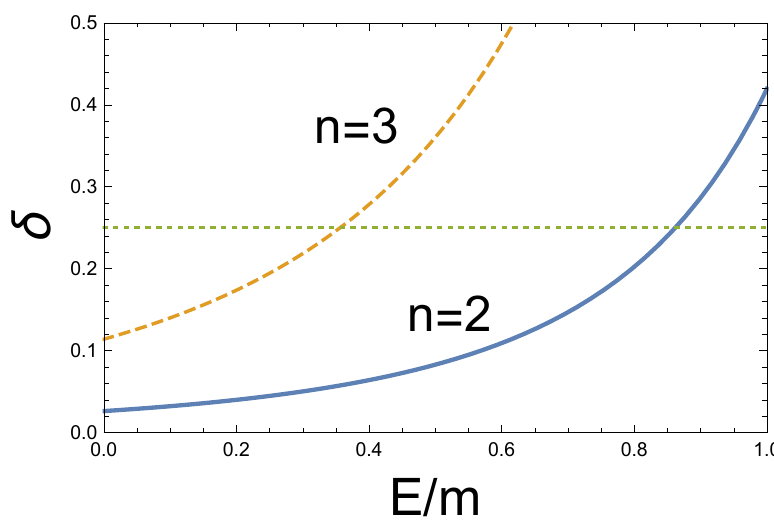
Figure 9. The interference factor δ as a function of binding energy for four and six photon decays according to Equation